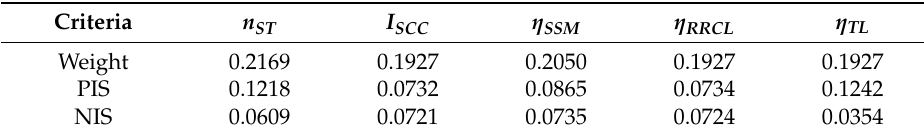
Table 10. Weight of criteria, PIS and NIS in Case 2.